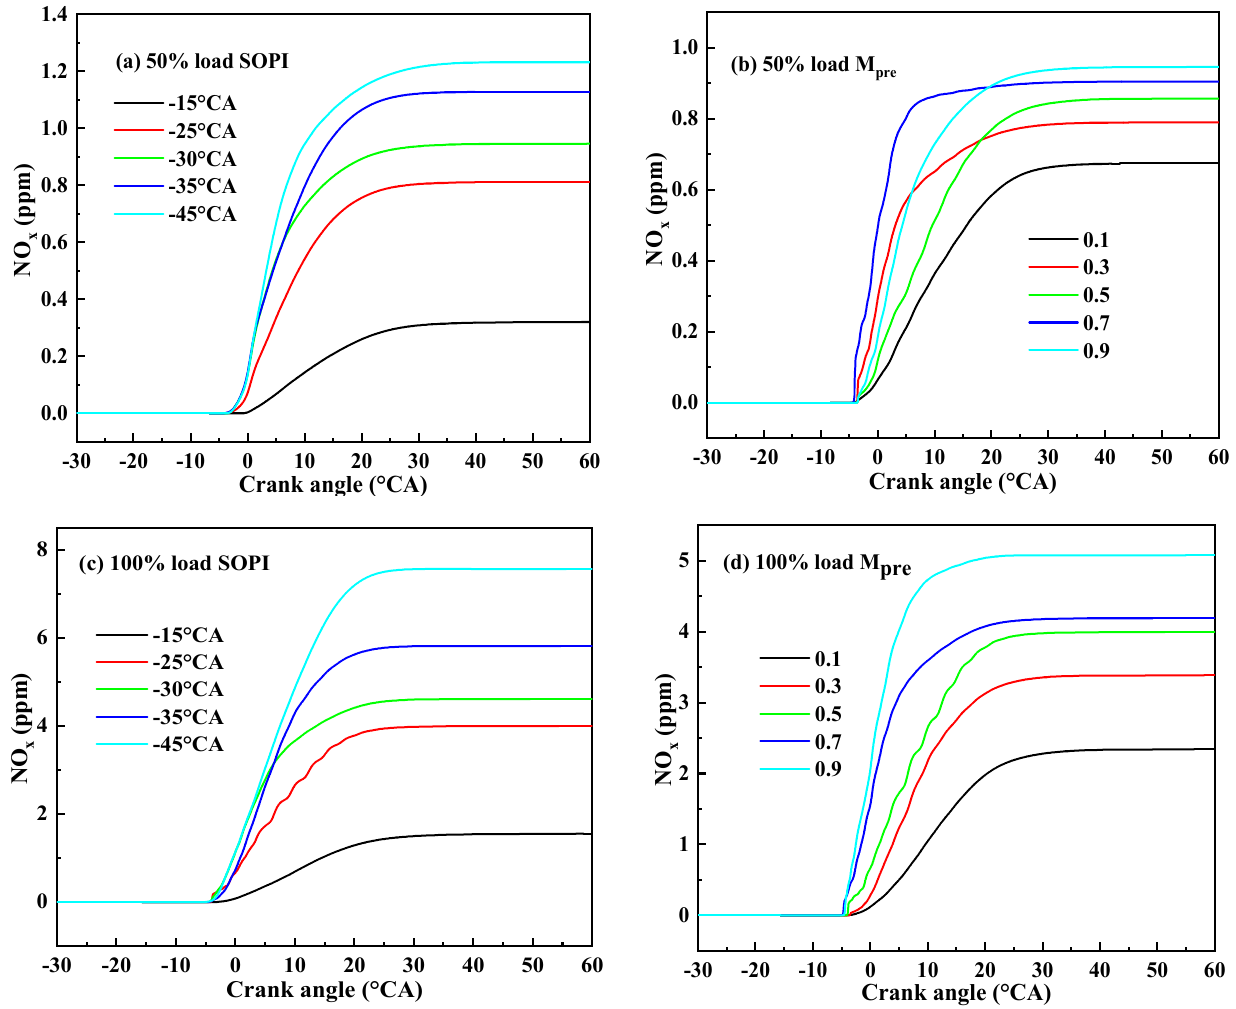
Figure 12. Comparisons of NO x emission under different load conditions.